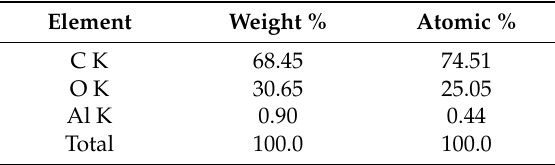
Table 3. Flag XRD of counterfeit banknote.